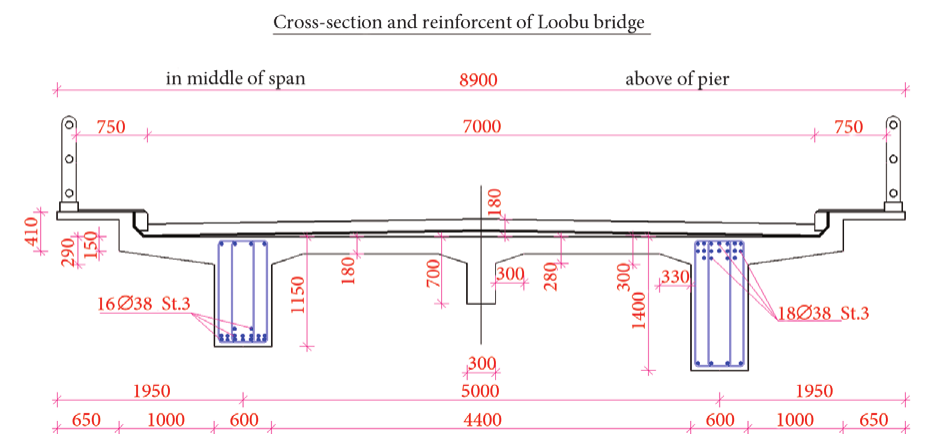
Fig. 2. A cross-section and reinforcement (depicted as blue dots and blue line in the beams) of the tested